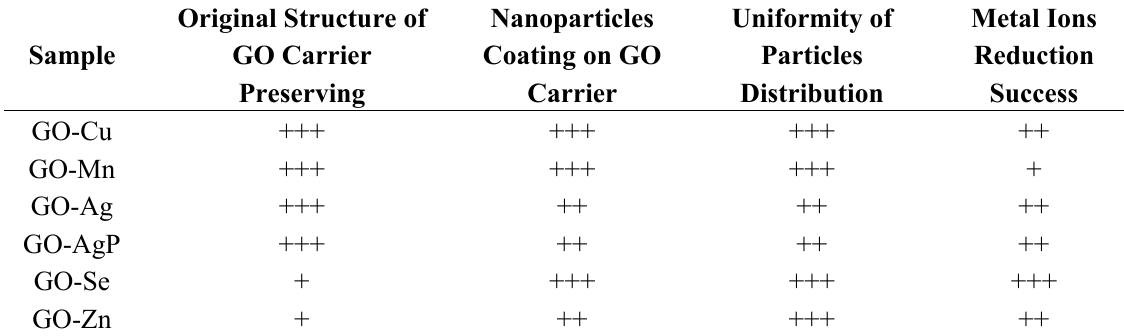
Table 1. Overview of some properties of synthesized GO